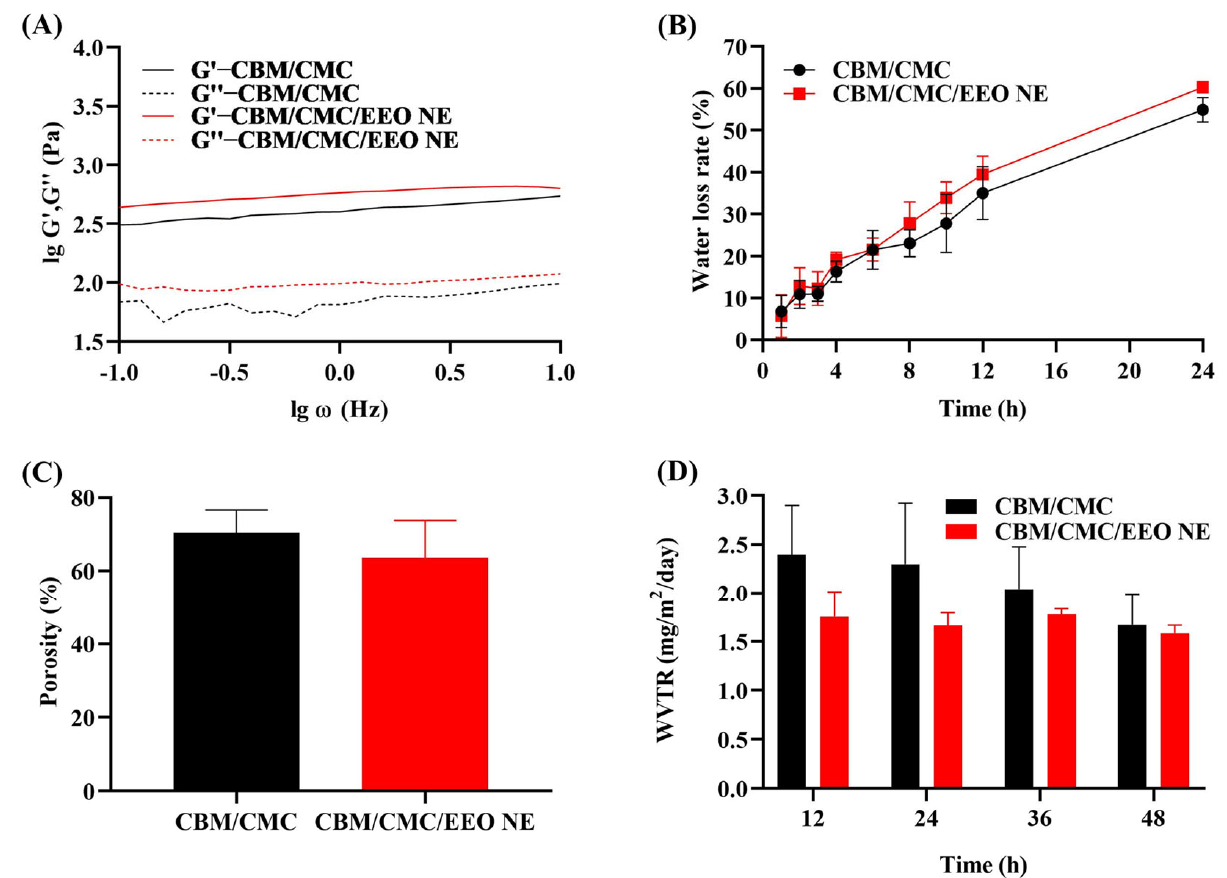
Figure 2. Properties of CBM/CMC/EEO NE. ( A ) Rheological test, G’—energy storage modulus, G”—loss modulus. ( B ) Water loss rate within 24h. ( C ) Porosity. ( D ) Water vapor transmission rate within 48 h.